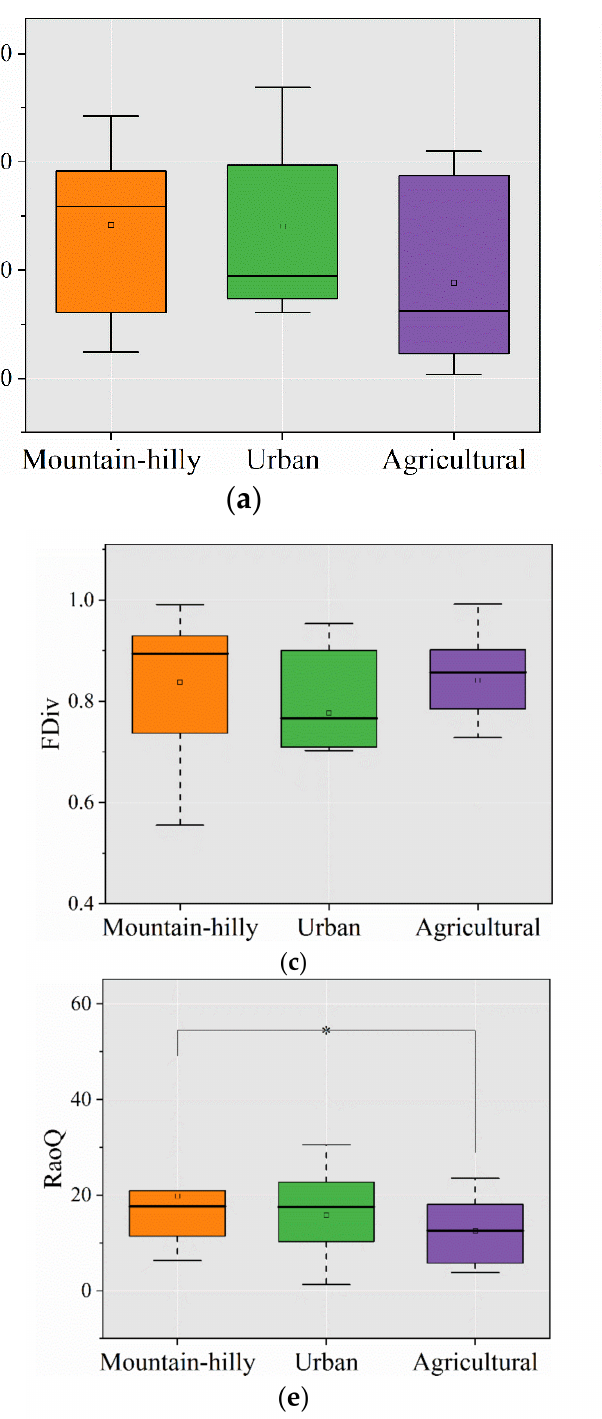
Figure 3. Box plots of functional diversity indexes of richness functional richness, functional evenness, functional divergence, functional dispersion, and Rao’s quadratic entropy of macroinvertebrates distributed across different land use types. * significance level at 0.05 for non-parametric